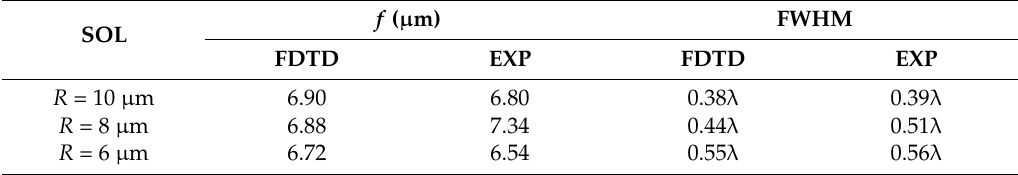
Table 4. The simulated and experimental FWHMs and focal lengths as the radius